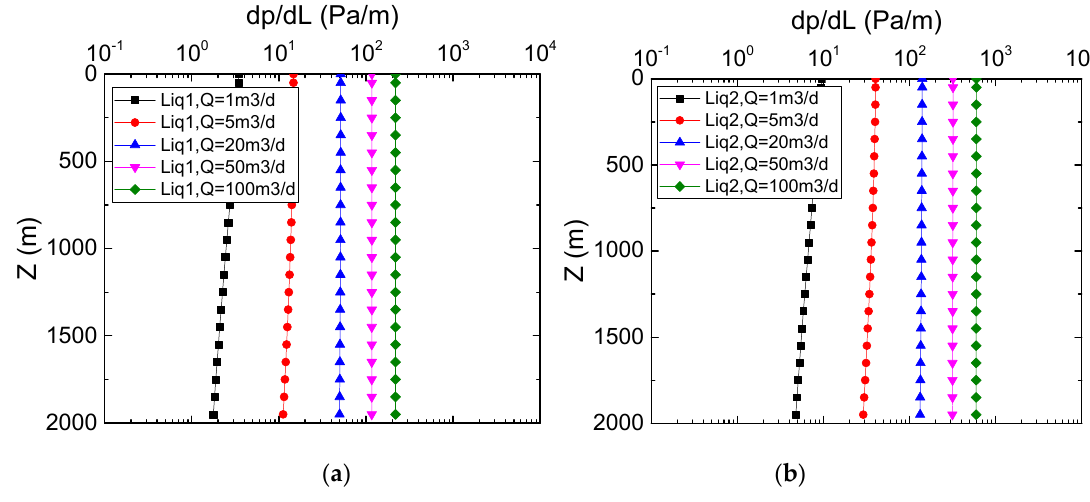
Figure 10. The injecting rates greatly influences the pressure drop.